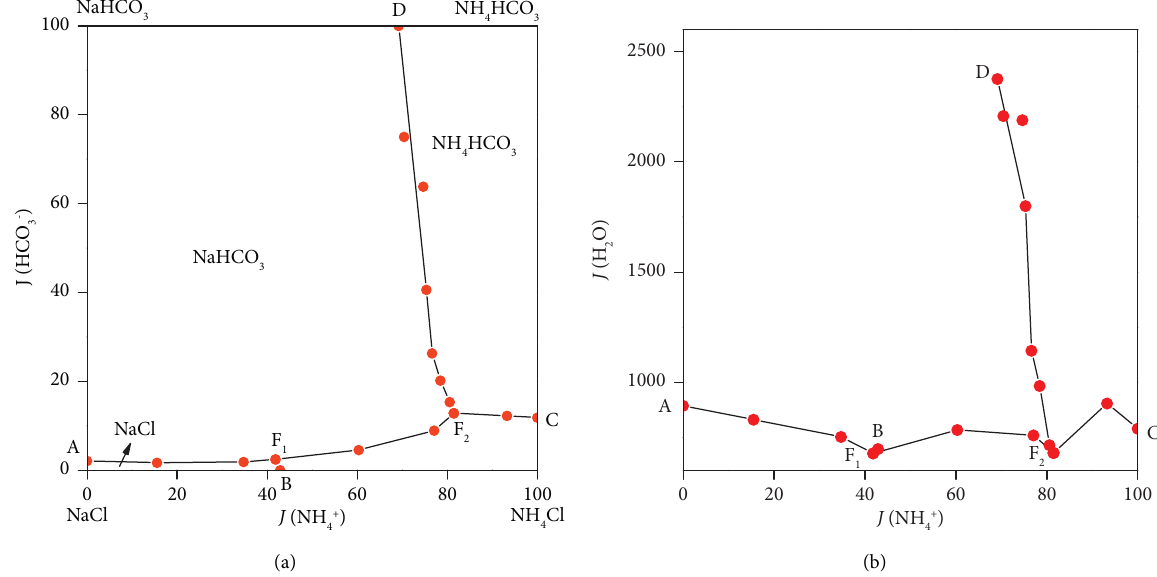
Figure 1: Phase diagram of the quaternary system (Na + , NH 4+ //Cl − , and HCO content